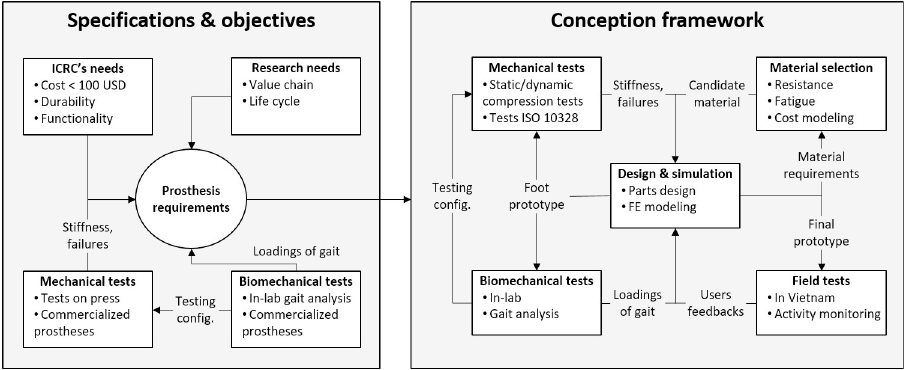
Fig 1. The framework of the project. This scheme shows the general structure of the project and the interactions between the different tasks. See the text for details.